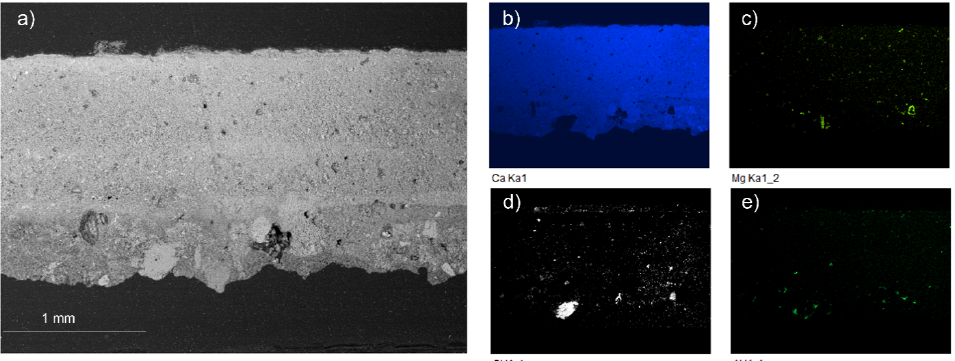
Figure 5. SEM-EDX results of sample B. ( a ) SEM image (BSE mode) and elemental maps of ( b ) calcium, ( c ) magnesium, ( d ) silicon, and ( e ) aluminum .